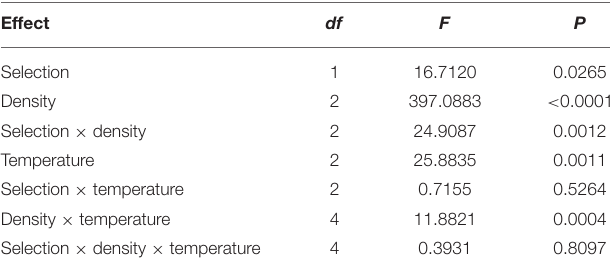
TABLE 4 | Results of ANOVA on CV of development time across individuals, within